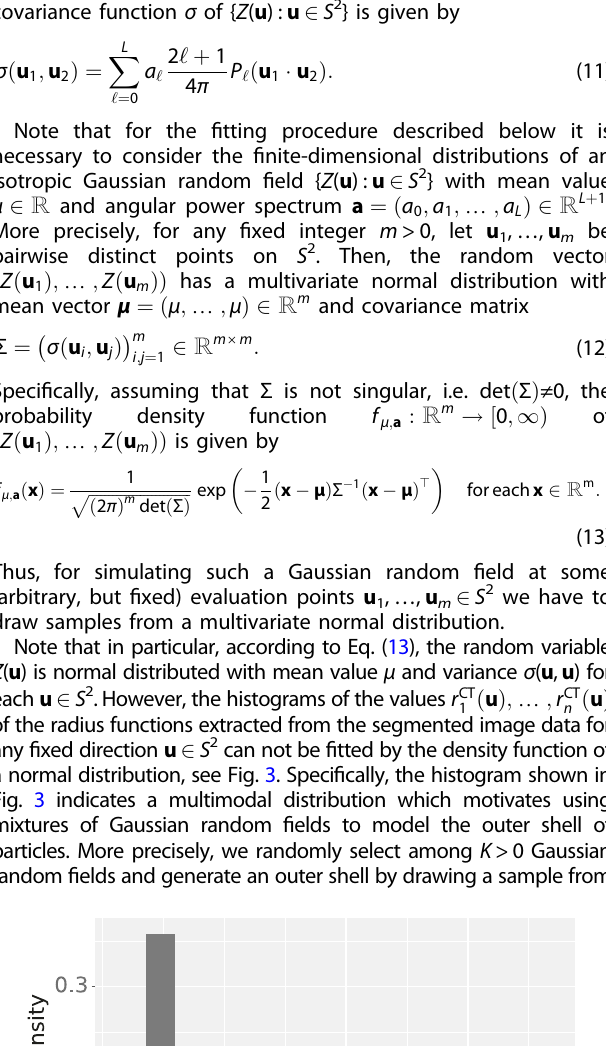
random fi elds and generate an outer shell by drawing a sample from